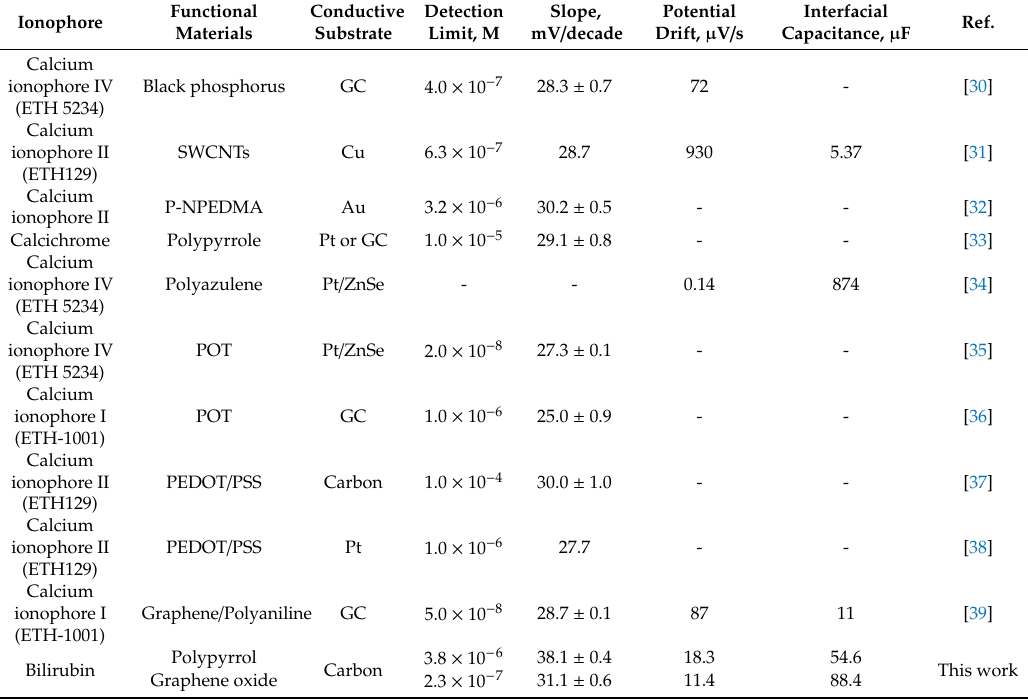
Figure 4. For all solid-state Ca 2+ /ISEs. Table 3. Between various functional materials used as solid-contact transducers in Ca 2+ -ISEs.